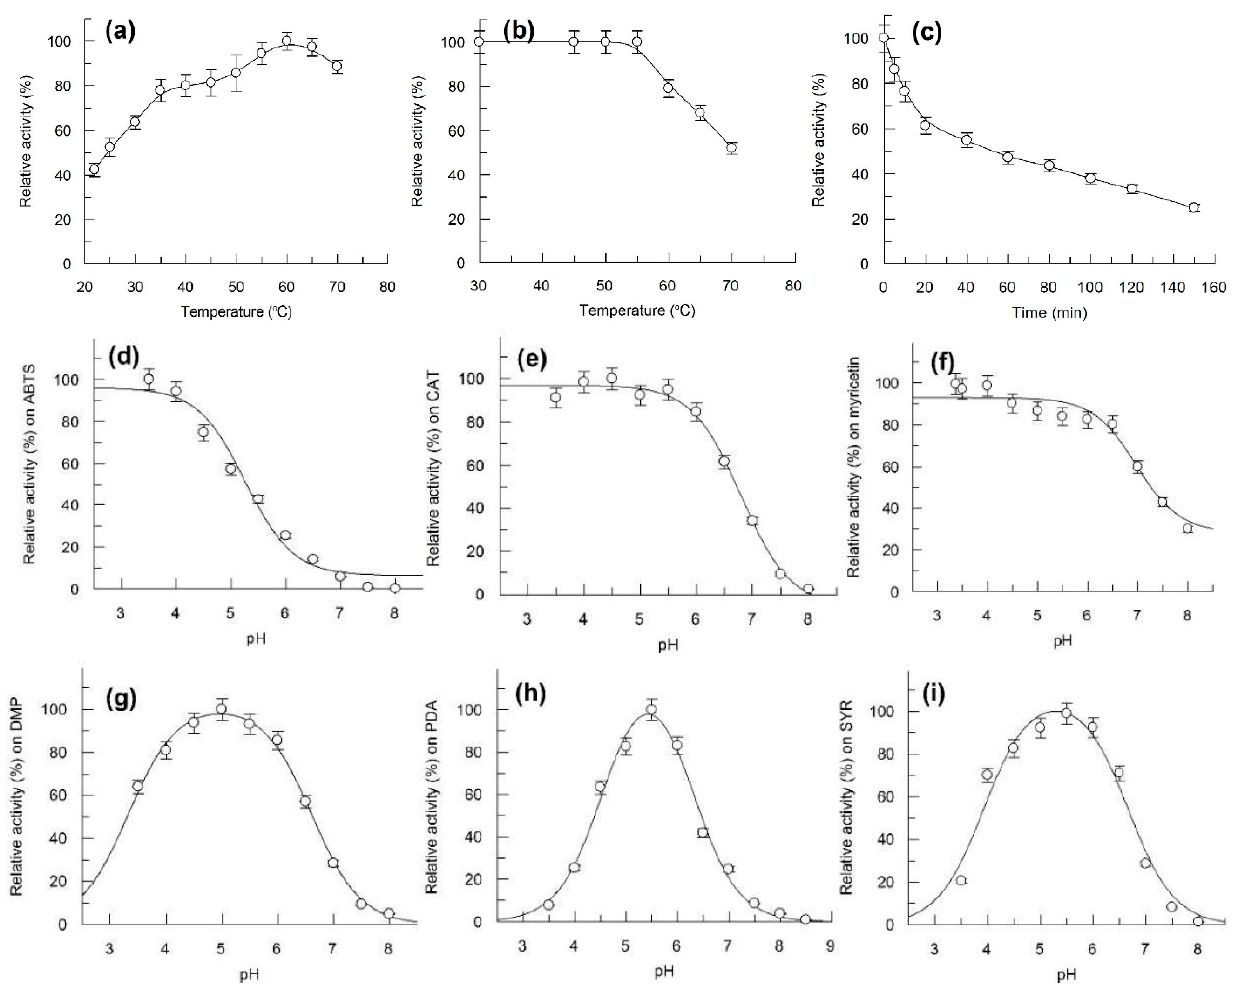
Figure 5. Effect of temperature on activity and stability of Bcl1 laccase and effect of pH on Bcl1 laccase activity. ( a ) activity of Bcl1 at different temperatures; ( b ) residual activity of Bcl1 incubated for 10 min at different temperature; ( c ) residual activity of Bcl1 at 60 °C, incubated for 0–140 min. ( d–i ) activity of Bcl1 at different pH; ( d ) ABTS, ( e ) catechol (CAT), ( f ) myricetin, ( g ) 2,6-dimethoxyphenol (DMP), ( h ) p -phenylenediamine (PDA) and ( i ) syringaldazine (SYR) were used as substrates in 60 mM Britton-Robinson buffer.